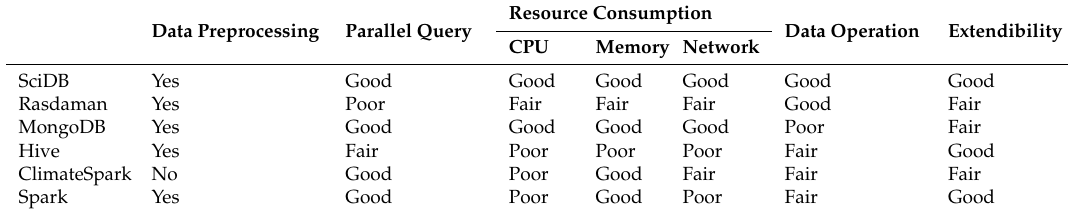
Table 8. Comparison of the data containers’ practical user experience and